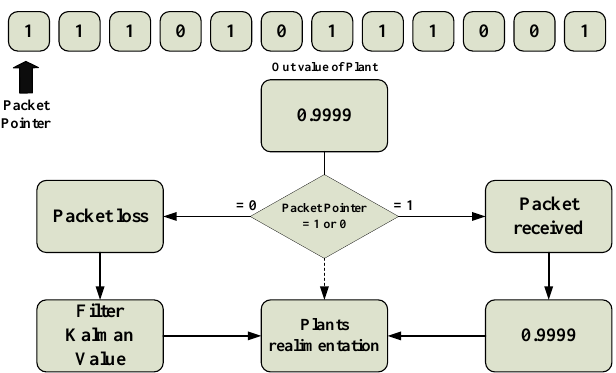
Figure 7. Method to analyse packet loss used on WCNS simulation. Algorithm 1 Kalman filter